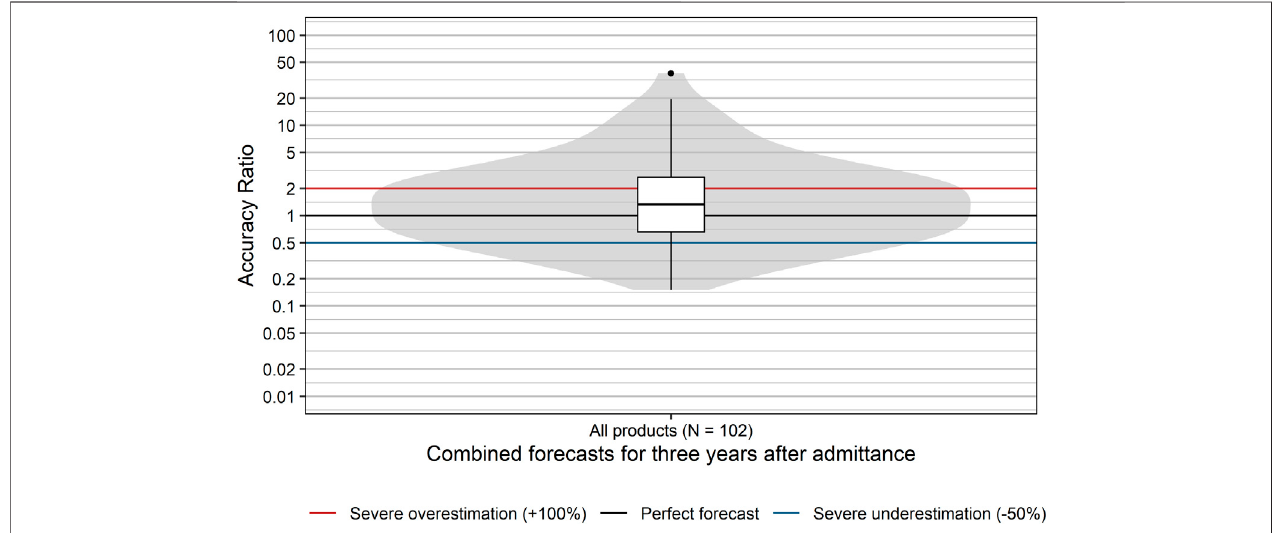
FIGURE1| Distributionofaccuracyratiosofproductswithapositivereimbursementdecision.Boxplotsandviolinplotsvisualizethedistribution ofaccuracyratios of combined forecasts for the 3 years after admittance. Due to their asymmetric nature, accuracy ratios are plotted on a logarithmic (base 10) scale to avoid visually overemphasizing overestimates compared to